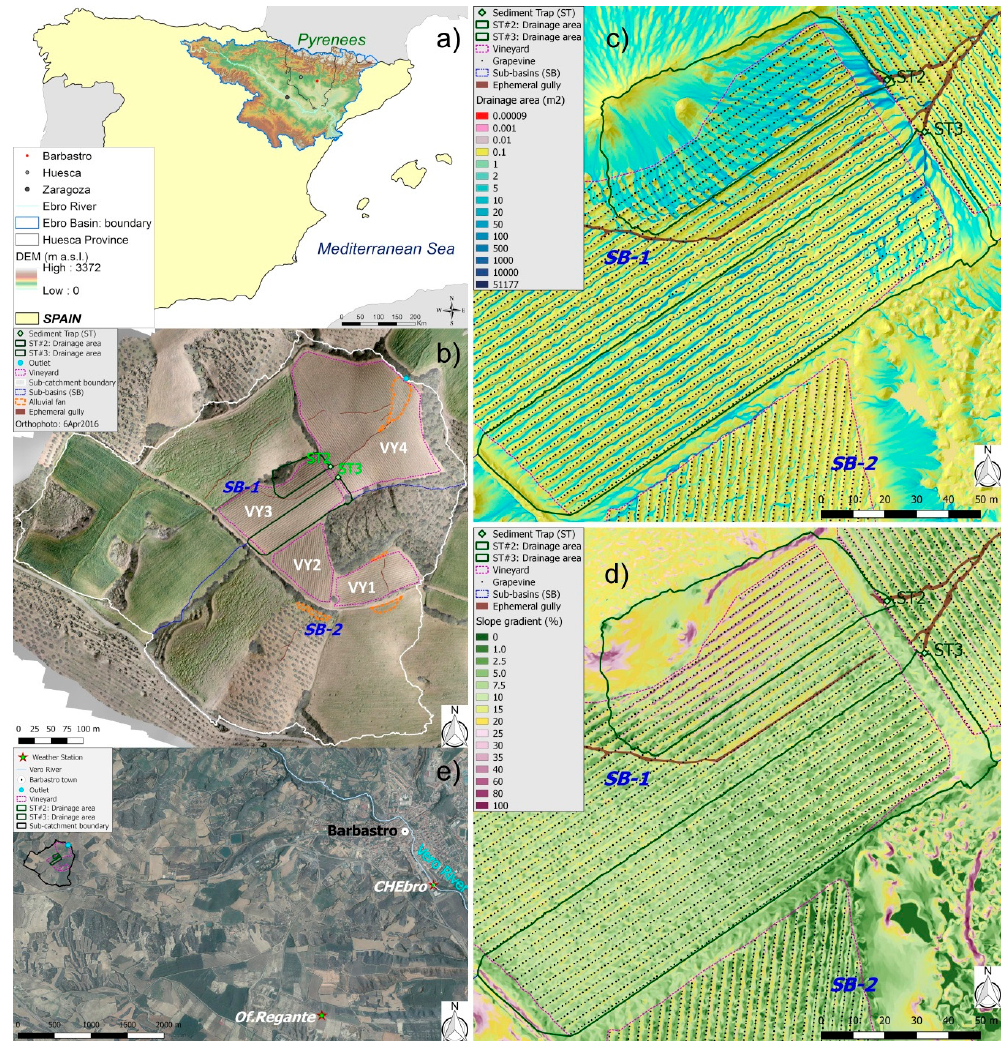
Figure 1. Location of the study area in Huesca Province, NE Spain ( a ); orthophoto and boundary of “Los Oncenos” sub-catchment and the location of the two sediment traps ( b ); drainage area ( c ) and slope gradient ( d ) of the two sediment traps; location of the two weather stations used in this study ( e ).